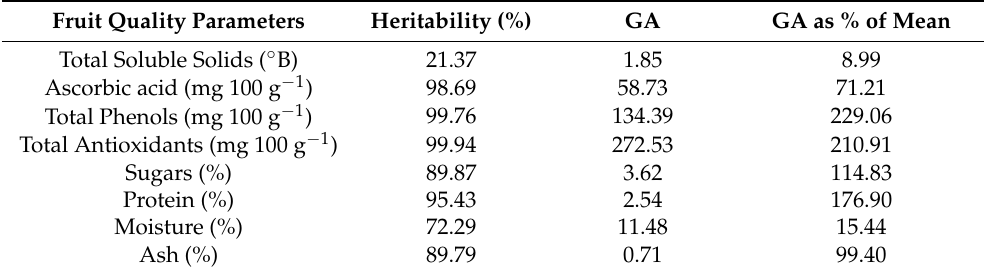
Table 5. Estimates of heritability, genetic advance (GA) and GA as percentage of the mean for fruit quality parameters determined for the fruits of 18 jujube genotypes in the two-year study